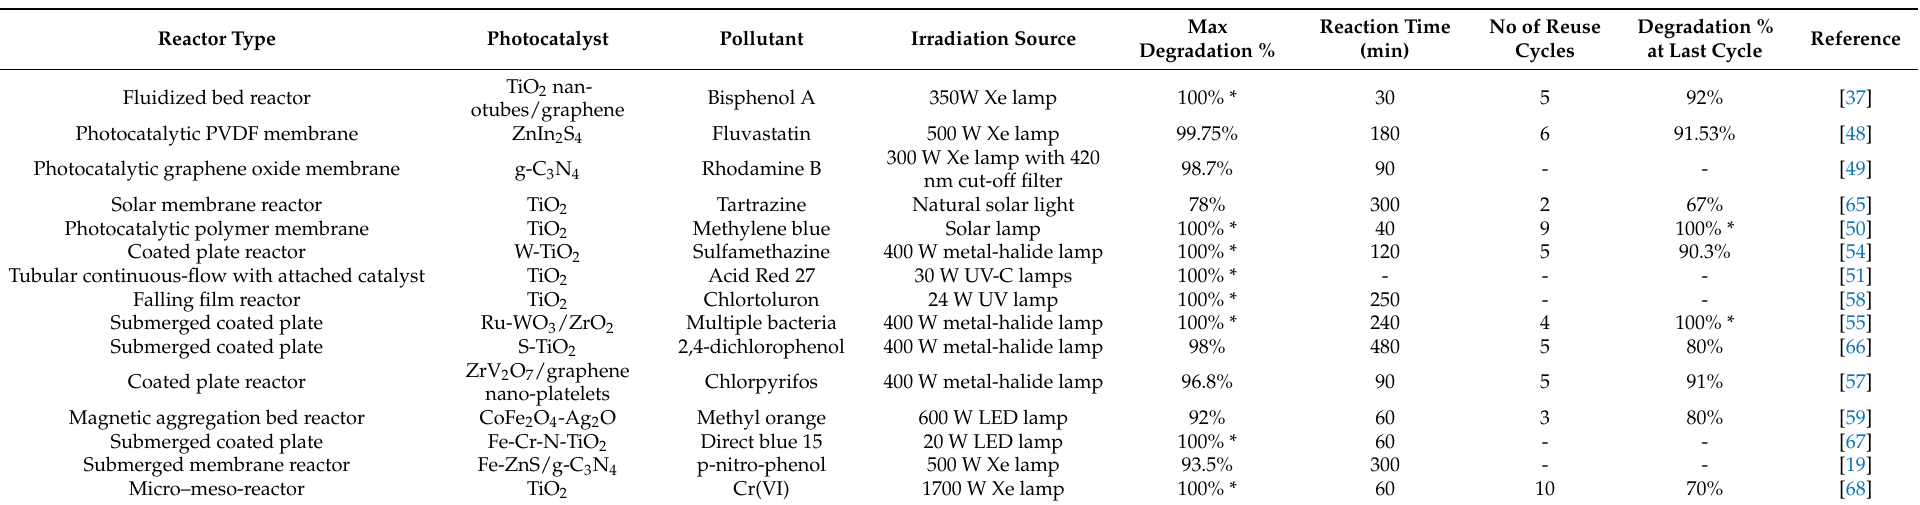
Table 1. Different reactors employing the photocatalysts in retained